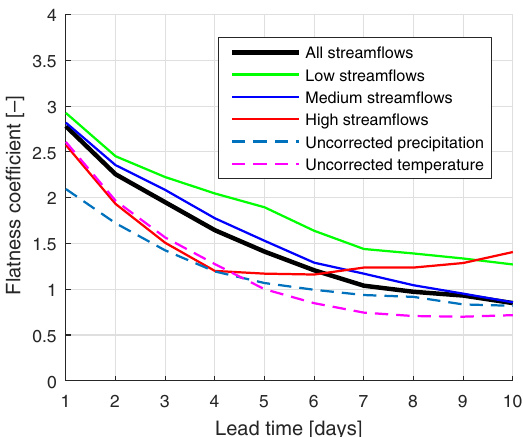
Figure 7. Rank histogram flatness coefficients. The flatness coef- ficients of the precipitation and temperature forecasts refer to lead time − 1.